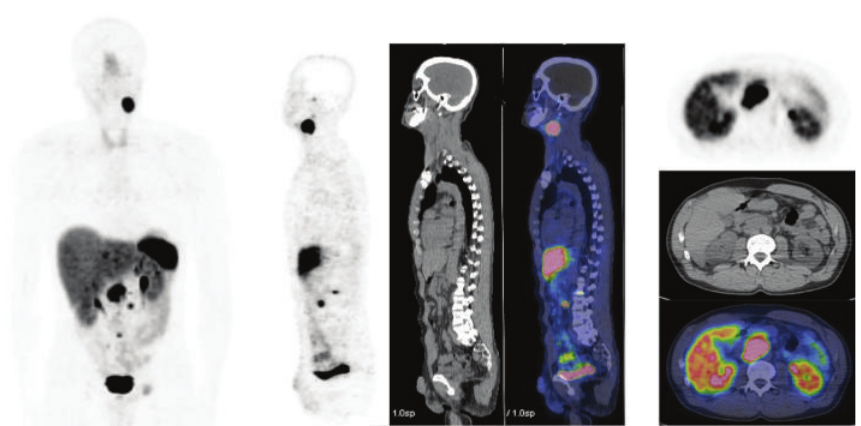
Figure 1: 68 Ga-DOTATOC PET/CT images (MIP, sagittal, axial) in a patient with metastatic paraganglioma.